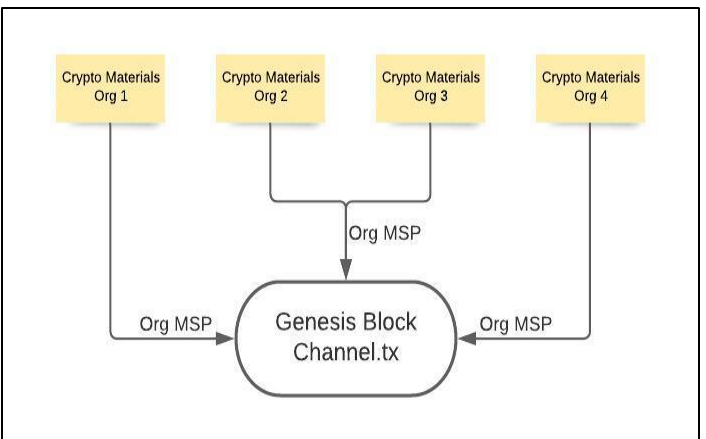
Figure 6. Genesis block development.